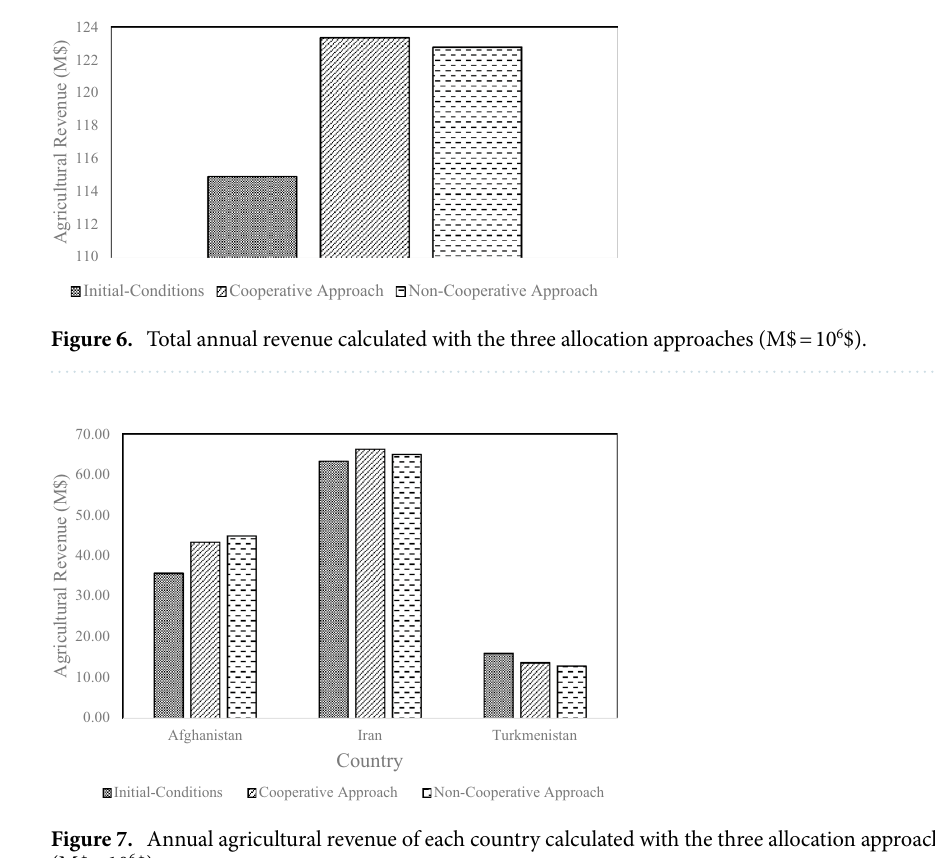
Figure 7. Annual agricultural revenue of each country calculated with the three allocation approaches (M$ = 10 6